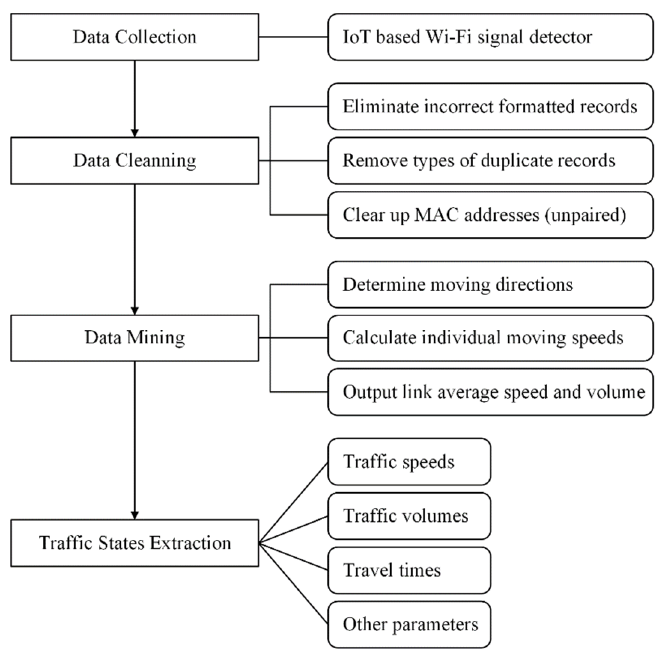
Figure 1. The scheme diagram of the proposed Wi-Fi signal-based traffic monitoring system.